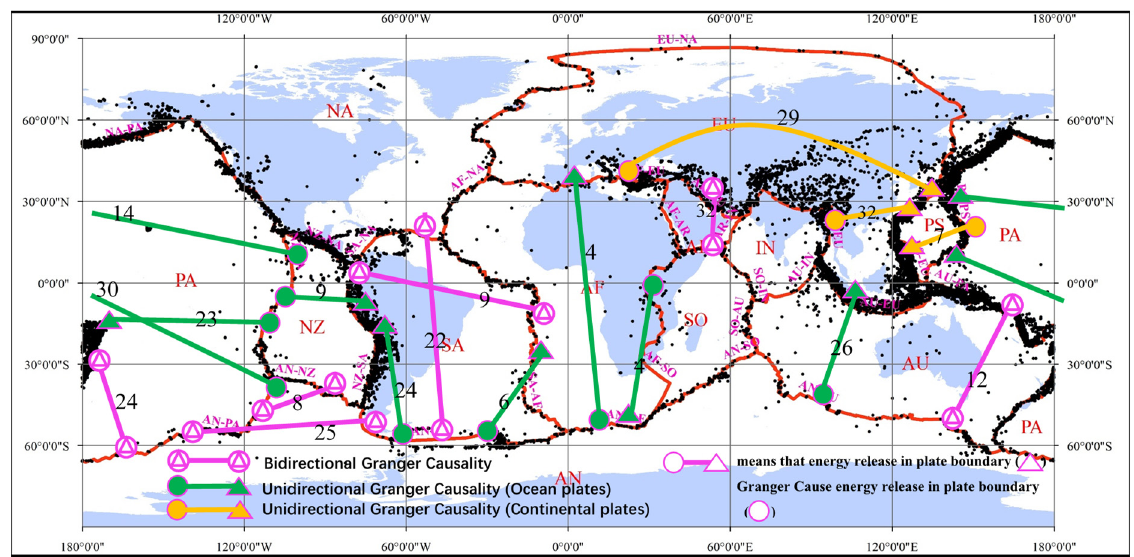
Figure 4. A map of Granger causality between the energy releases at plate boundaries is reported. The red marks indicate Bidirectional Granger Causality between the energy releases at plate boundaries. The green marks indicate unidirectional Granger causality between the energy releases at plate boundaries of Ocean plates. The yellow marks indicate unidirectional Granger causality between the energy releases at the plate boundaries of the continental plates. In the results of unidirectional Granger causality, the energy release at the boundary is shown by the triangular mark, and the Granger cause energy release at the boundary is shown by the circular mark.